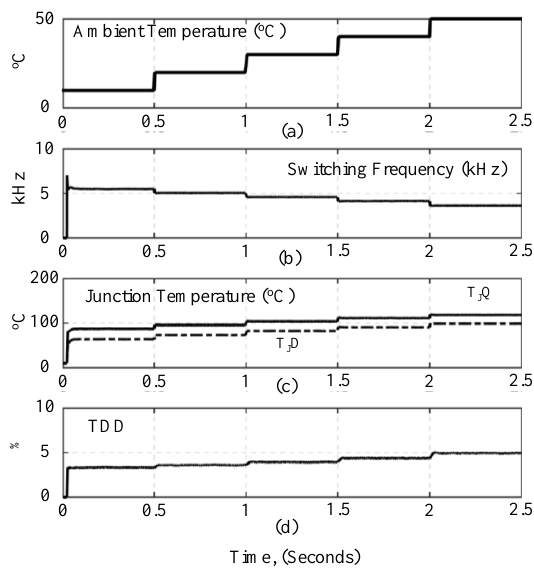
Figure 7. Effect of the ambient temperature on the switching frequency, junction temperatures, and TDD at rated load, ( a ) ambient temperature in °C ( b ) the switching frequency in kHz; ( c ) the IGBT and diode junction temperatures in °C; ( d ) the TDD of the output current.